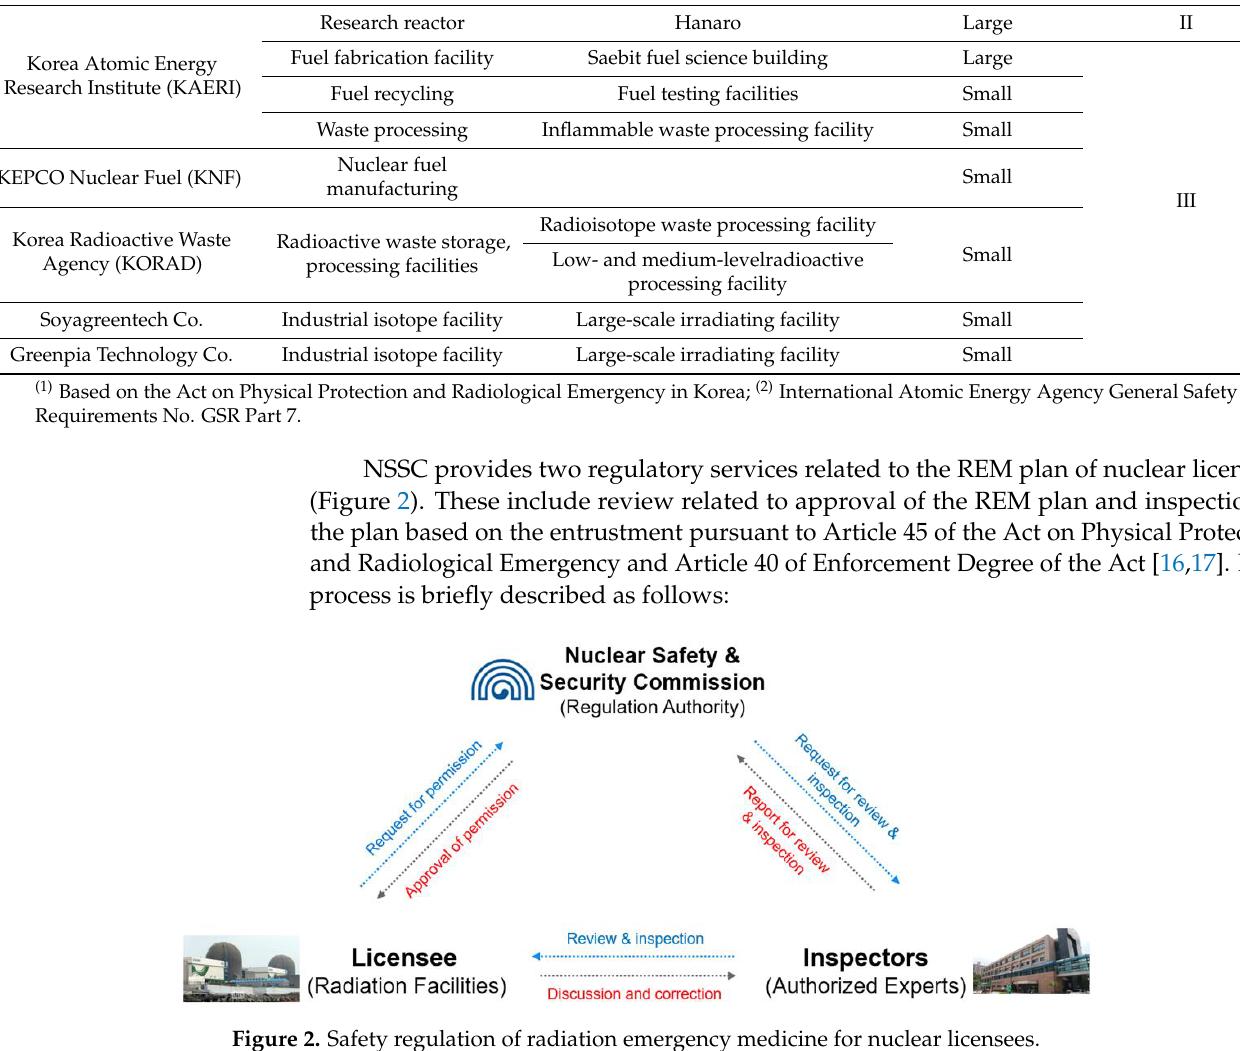
Figure 2. Safety regulation of radiation emergency medicine for nuclear licensees.